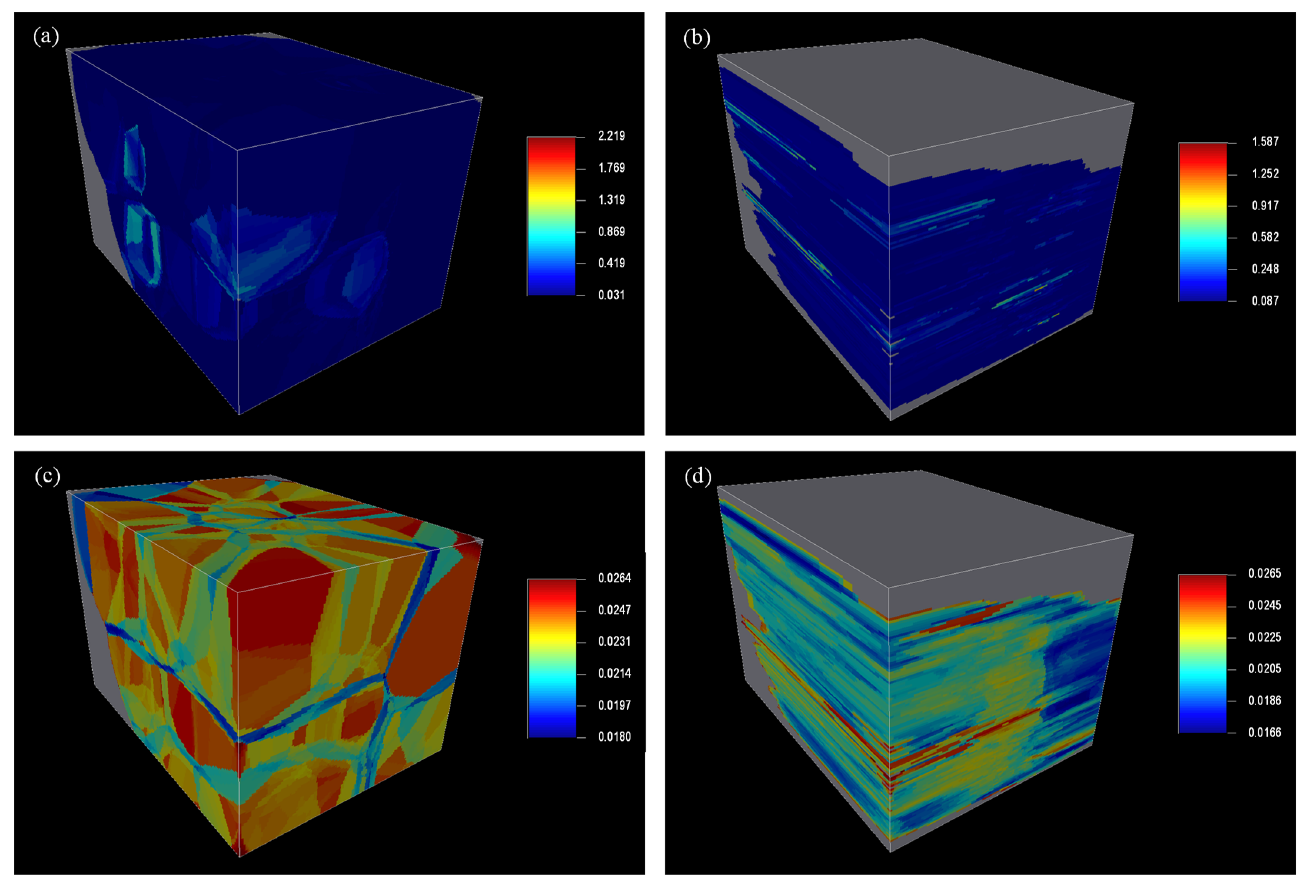
Figure 8. 3D kriging block model that was produced by: ( a ) isotropy search ellipsoid, and ( b ) anisotropy search ellipsoid, and their respected kriging variances ( c , d ).